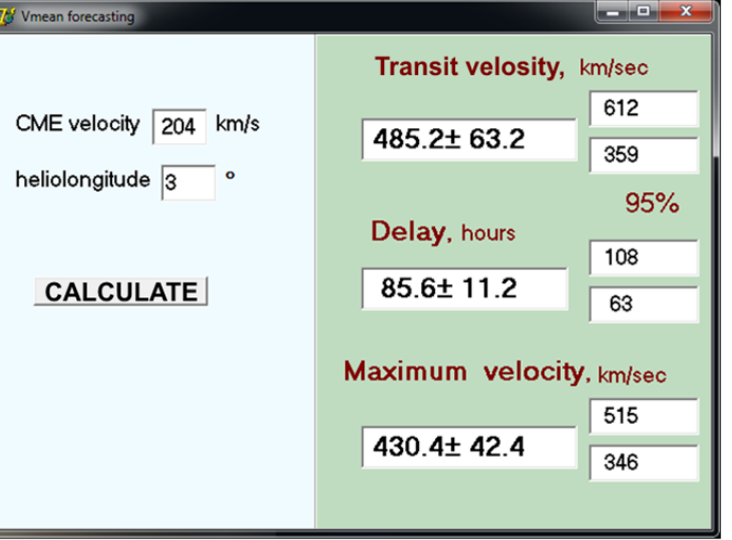
Figure 10. Screenshot of the program for calculating the expected transit and maximum speed and propagation time of ICMEs created on the basis of the described